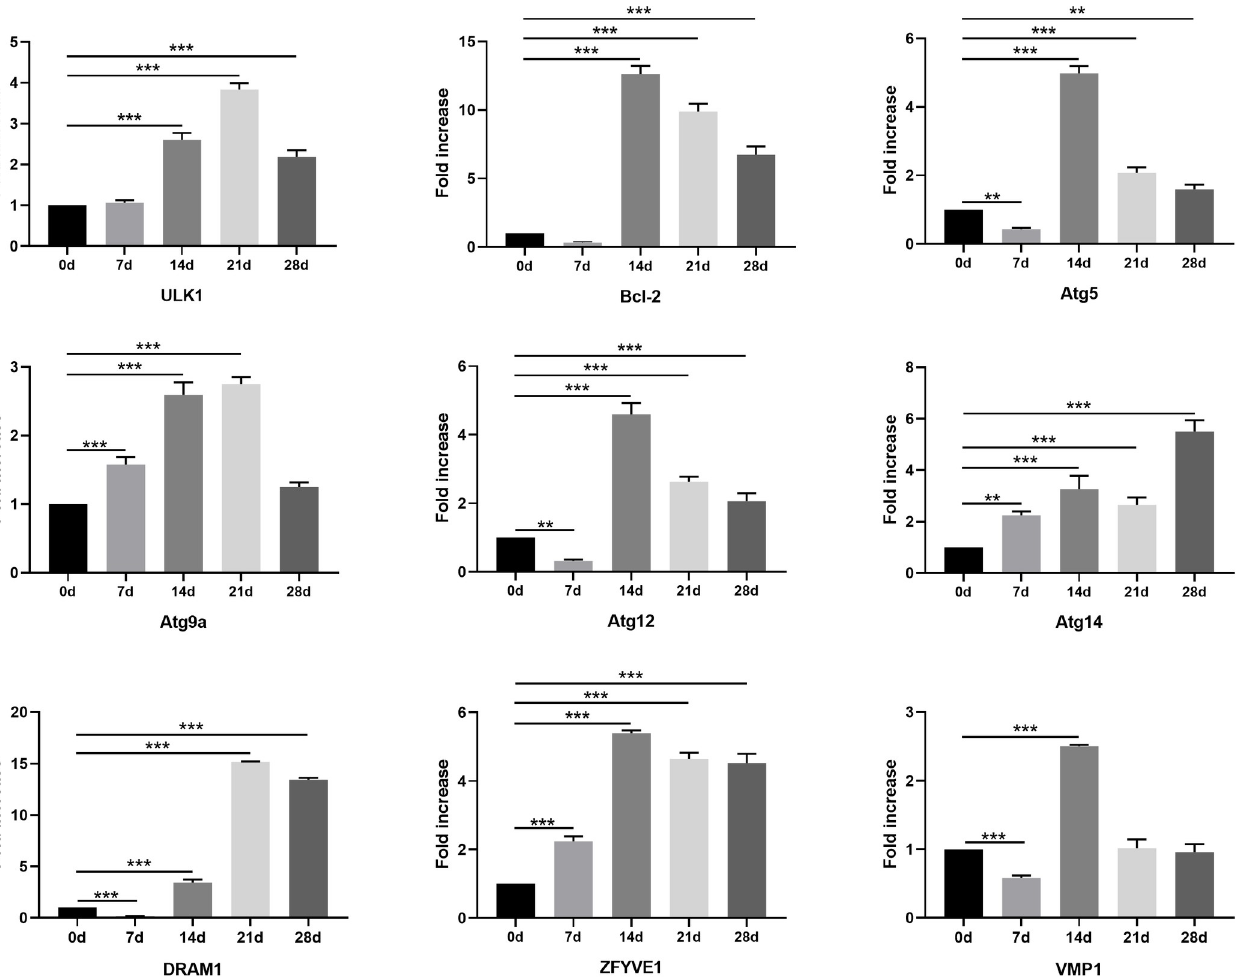
Fig 3. Changes in the transcriptional level of additional autophagy-related markers in vivo . Expression of ULK1, Bcl-2, Atg5, Atg9a, Atg12, Atg14, DRAM1, ZFYVE1, and VMP1 mRNA in the diaphragms of T . spiralis -infected mice on 0, 7, 14, 21, and 28 dpi. The data represent at least 3 independent experiments and are expressed as mean ± SD. p < 0.05( � ), p < 0.01( �� ), p < 0.001( ��� ).